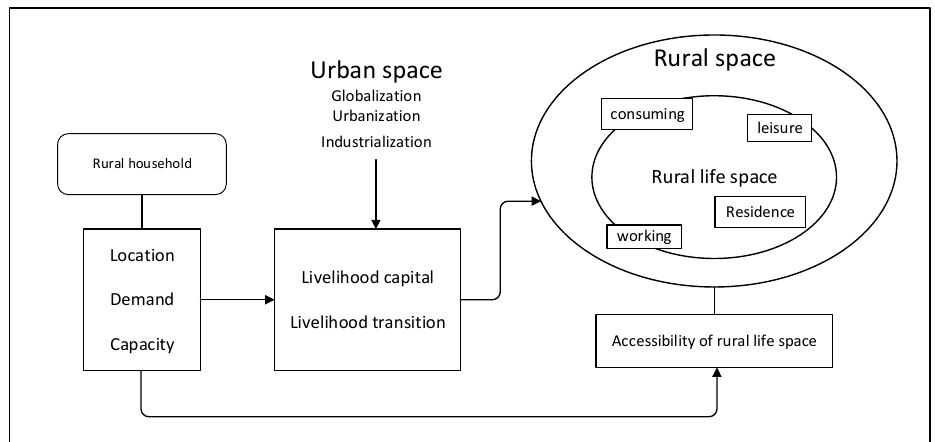
Figure 1. A framework for accessibility of rural life space.